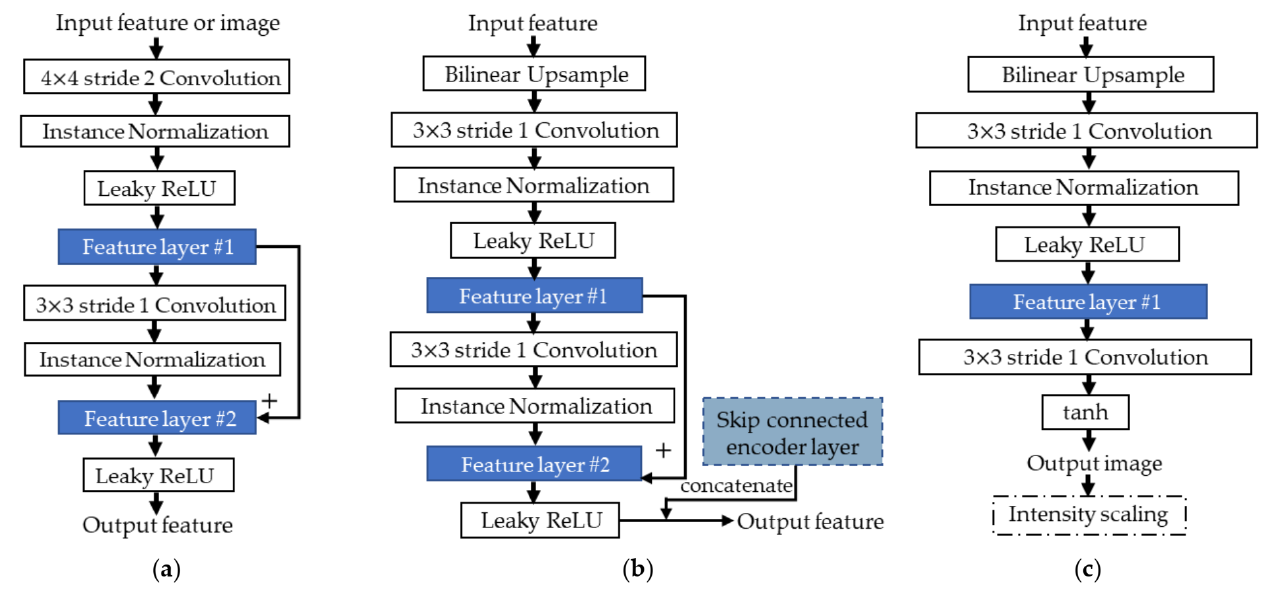
Figure 7. Detailed structure diagrams of basic blocks in the proposed network. ( a ) The structure of encoder block (the dotted-line frame (a) in Figure 6). ( b ) The structure of decoder block (the dotted-line frame (b) in Figure 6). ( c ) The structure of output block (the dotted-line frame (c) in Figure